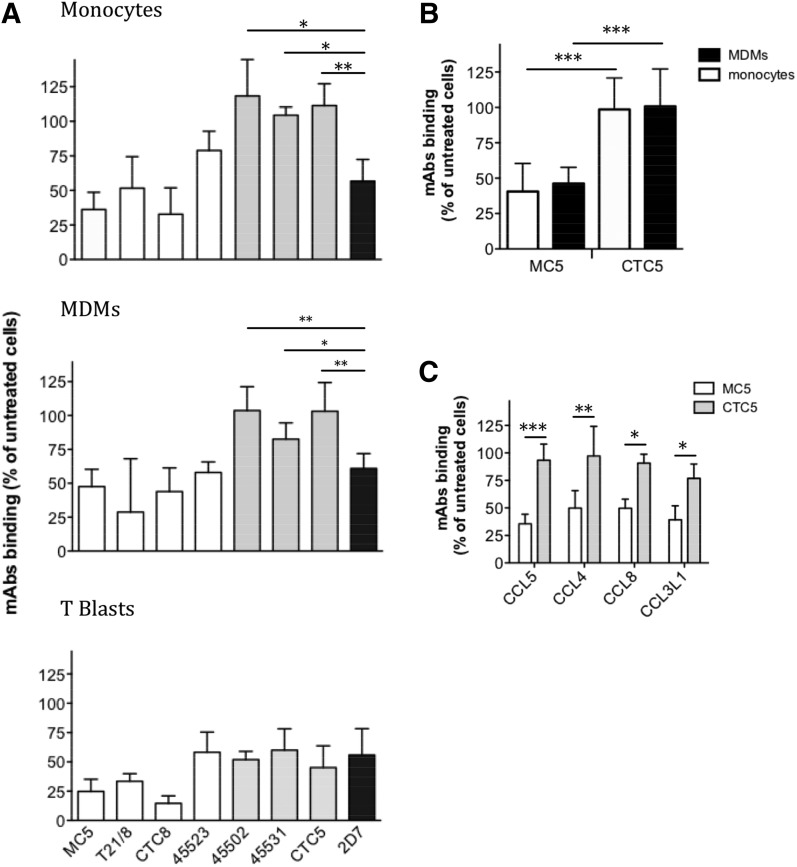
Chemokine-mediated CCR5 down-modulation on primary human blood-isolated cells. (A) Monocytes, MDMs, and T cell blasts were treated with CCL5 (100 nM) for 1 h at 37°C before samples were immunolabeled for cell surface CCR5 using the indicated mAbs at 5 µg/ml and analyzed by flow cytometry. Results are expressed as the percentage of expression on cells exposed to the medium alone (untreated) from N = 5 donors. Monocytes or MDMs down-modulated (white bars) and unchanged epitopes (light gray bars) are compared with 2D7 (black bar). (B) Statistical difference in cell surface levels of MC5 and CTC5 epitopes after CCL5 treatment of monocytes (N = 10) and MDMs (N = 13). (C) Cell surface levels of MC5 and CTC5 epitopes were measured after 1 h treatment of MDMs with various CCR5-binding chemokines (100 nM; N = 3). Each graph represents the means ± sd from experiments performed in triplicate on cells from N donors. *P ≤ 0.05. **P ≤ 0.01, ***P ≤ 0.001 by unpaired 2-tailed Student’s t test.